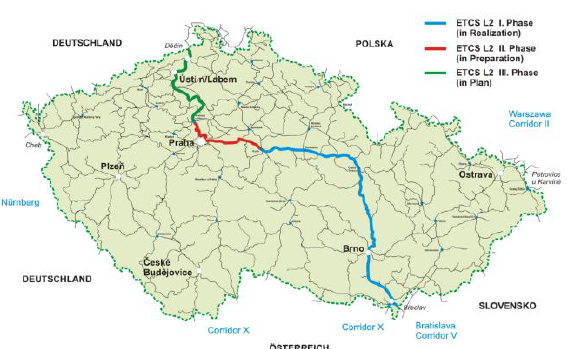
Figure 5. Map of ETCS implementation [2]